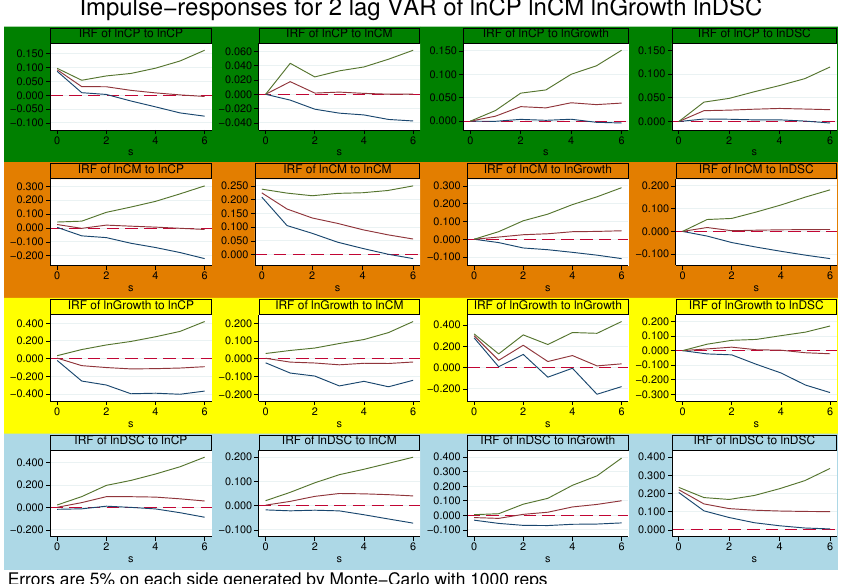
Errors are 5% on each side generated by Monte−Carlo with 1000 reps Figure 9. The first row (in green) indicates, respectively, the impulse response of the corporate performance to itself (lnCP), corporate management (lnCM), growth capacity (lnGrowth), and debt service capacity (lnDSC); the second row (in orange) indicates, respectively, the impulse responses of corporate management on corporate performance (lnCP), itself (lnCM), growth capacity (lnGrowth), and debt servicing capacity (lnDSC); the third row (in yellow) indicates, respectively, the impulse responses of growth capacity to corporate performance (lnCP), corporate management (lnCM), itself (lnGrowth), and debt servicing capacity (lnDSC); the fourth row (in light blue) indicates, respectively, the impulse responses of debt servicing capacity to corporate performance (lnCP), corporate management (lnCM), growth capacity (lnGrowth), and itself (lnDSC). (5) As can be seen from Figure 10, the impulse response of company management to itself is stronger, with a significant positive impact from period 1 to period 6, but the positive trend gradually decreases. Supply chain management has a strong impulse response to corporate management, with a significant positive effect from period 1 to period 5, and the positive effect tends to increase and then decrease. Supply chain management has a more robust impulse response on debt service capacity, with a significant positive impact from period 1 to period 3, and the positive impact trend is increasing and then decreasing. Growth capacity has a more robust impulse response to itself, with a significant positive impact continuously from period 1 to period 3, but the positive impact trend decreases, then increases, and finally decreases and disappears. Debt service capacity has a more robust impulse response on its own, with a continuous significant positive effect from period 1 to period 6, but the positive effect tends to